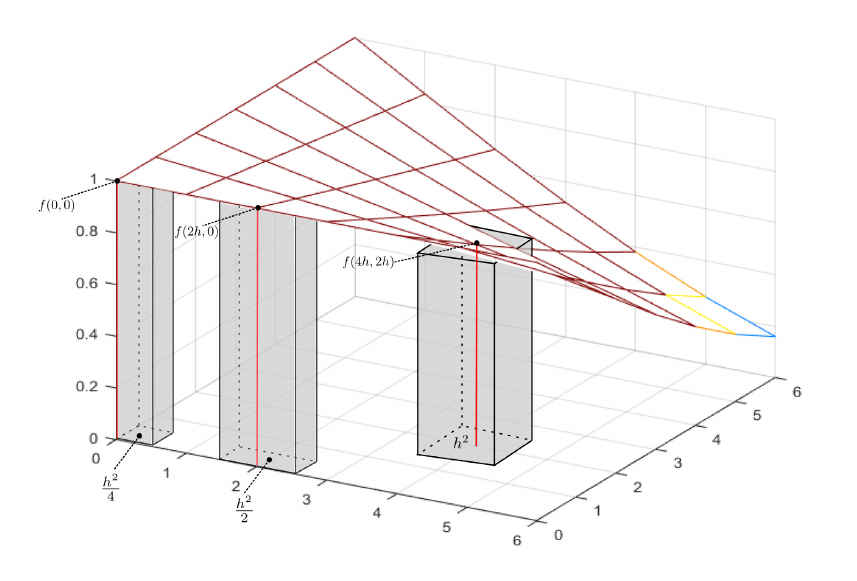
Figure 2. Computing the integral term in (5) as a sum of